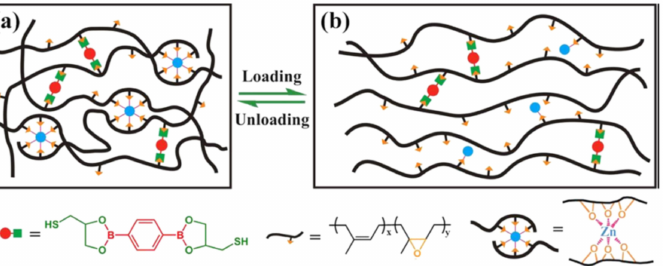
Figure 5. ( a ) ENR networks with dual cross-links of dynamic boronic ester bonds and noncovalent Zn 2+ − O coordination bonds. ( b ) Reversible breaking and reforming of Zn 2+ − O coordination bonds during loading–unloading tests. Adapted with permission from Reference [85]. Copyright (2019) American Chemical Society.